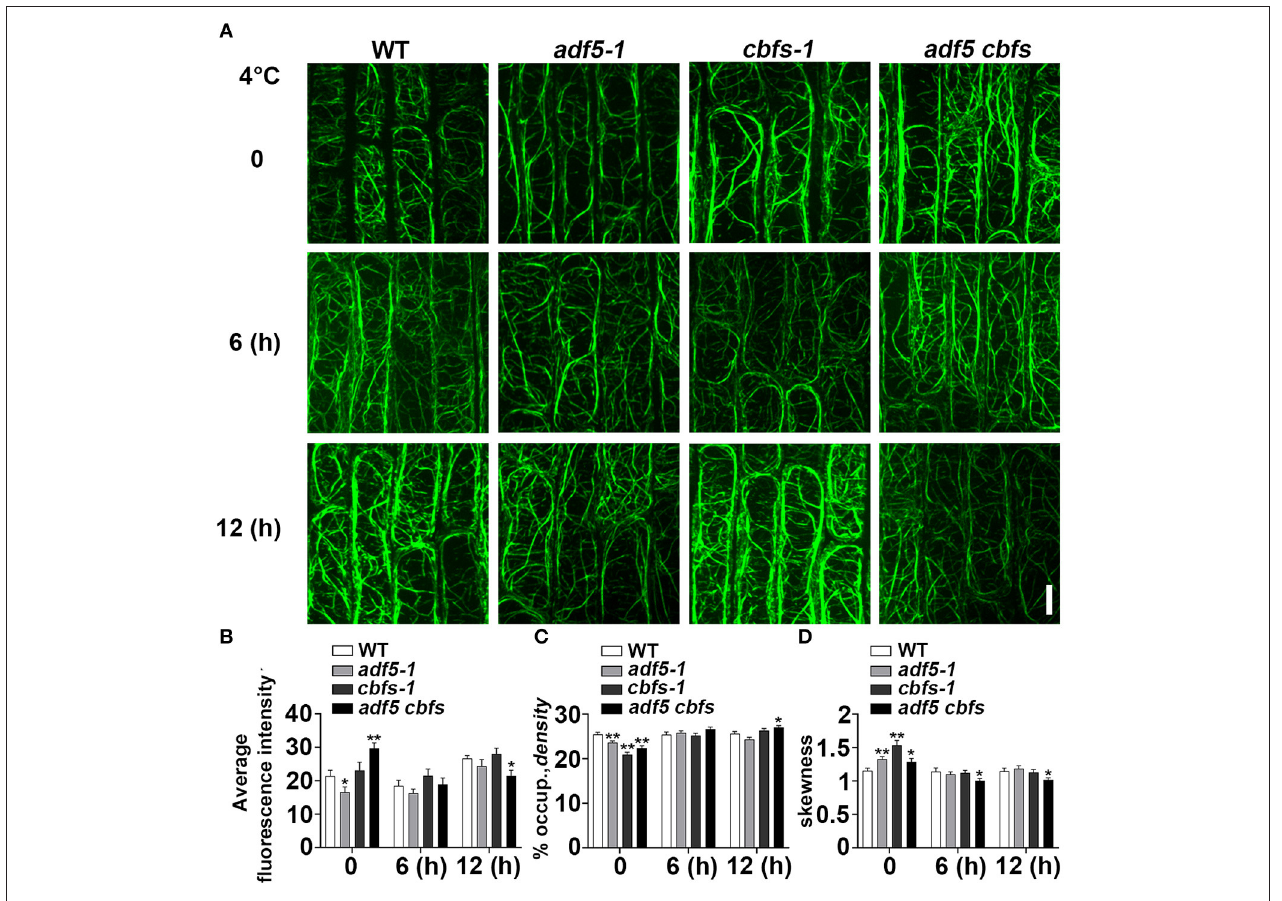
FIGURE 5 | Actin cytoskeleton array rearranges in response to cold treatment. (A) Five-day-old seedlings expressing ABD2-GFP were used for fluorescence collection. Images of the cortical actin cytoskeleton array in epidermal cells from the root elongation transition zone of WT, adf5-1, cbfs-1, and adf5 cbfs treated at 4 ◦ C for different durations. Scale bar = 10 µ m. (B) The average intensity of fluorescence of the GFP signal in WT, adf5-1, cbfs-1, and adf5 cbfs root elongation transition zone cells. (C) Average actin cytoskeleton density of WT, adf5-1, cbfs-1, and adf5 cbfs root elongation transition zone cells. (D) The extent of actin cytoskeleton bundling (skewness) of WT, adf5-1, cbfs-1, and adf5 cbfs root elongation transition zone cells. The values represent the means ± SEM ( n = 60 cells per genotype. * P < 0.05; ** P < 0.01; Student’s two-tailed t